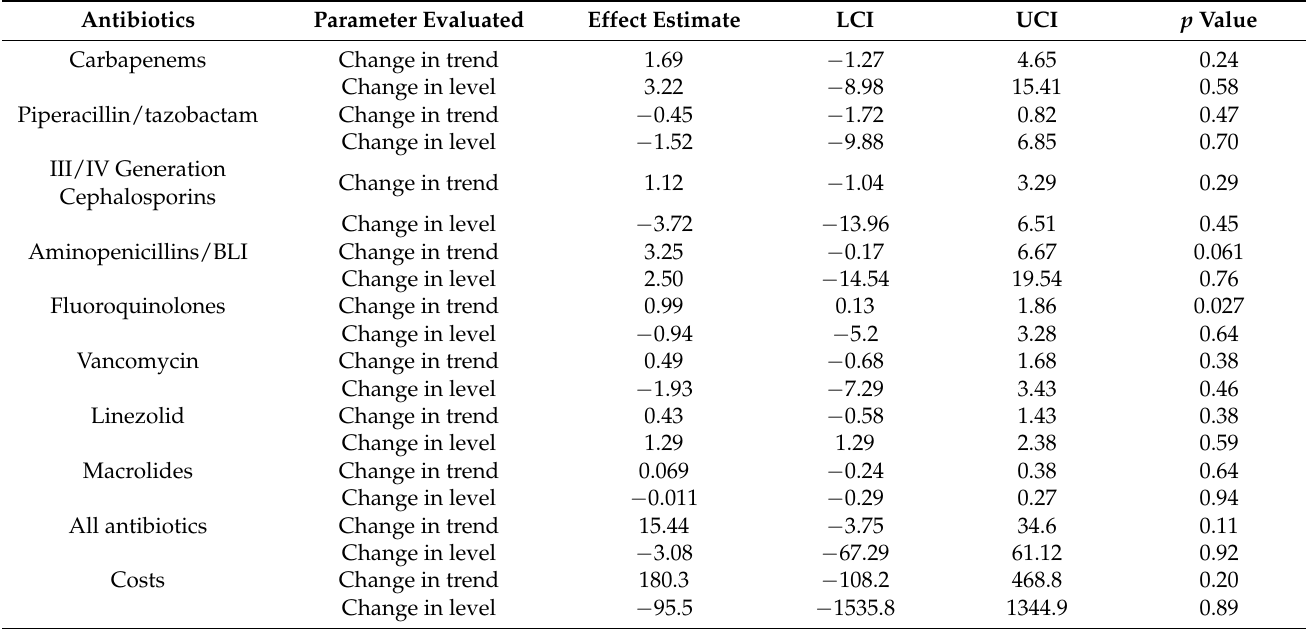
Table 1. Effect of the ASP interruption during COVID-19 pandemic on antibiotic consumption in the 4 medical units included in the study.